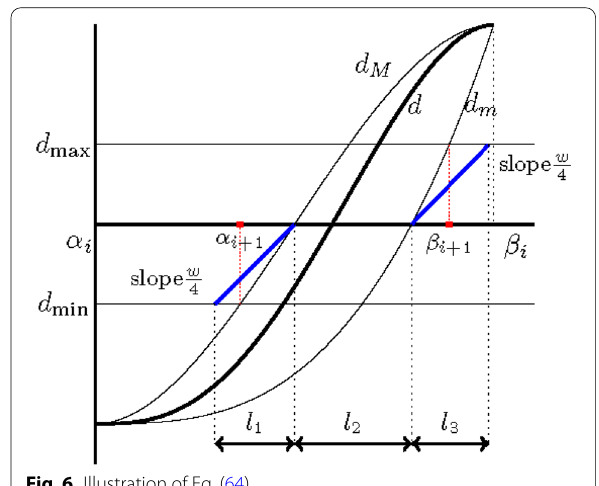
Fig. 6 Illustration of Eq. (64)